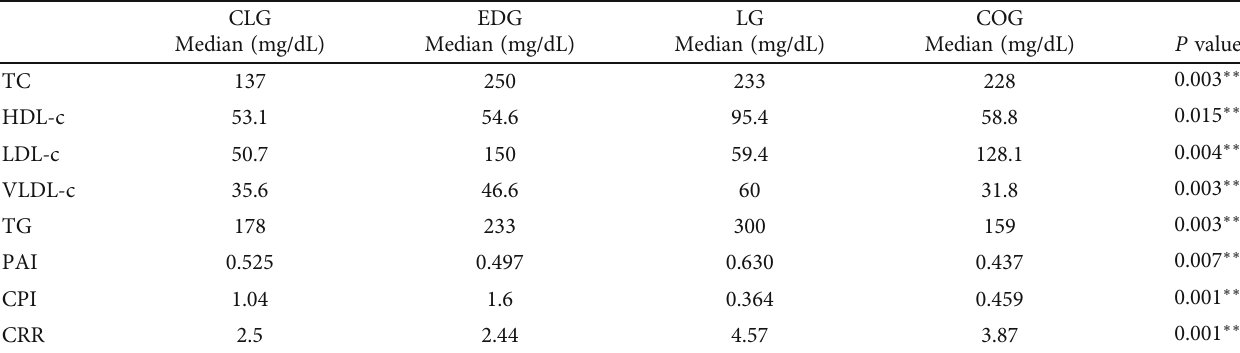
Table 4: Lipid pro fi le of supplemented mice for 8